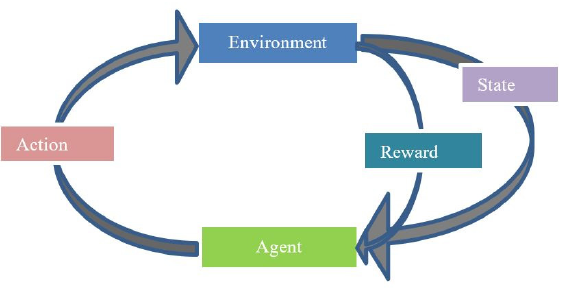
Figure 1. Reinforcement learning ecosystem.